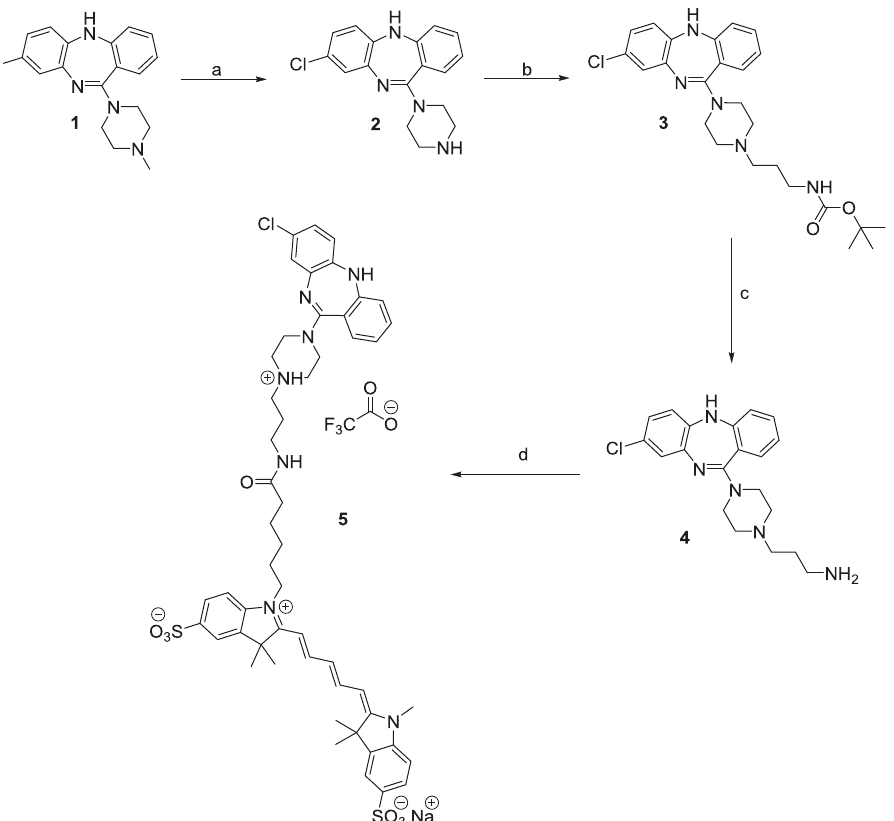
Fig. 3 Synthesis of sulfo-Cy5 fl uorescently labelled derivative of clozapine. Reagents and conditions: a 1-chloroethyl chloroformate, 1,2-DCE, N 2 ,